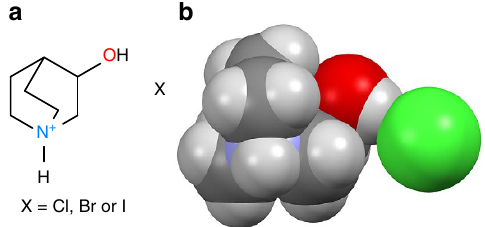
Figure 1 | Chemical structures of ( R )-( (cid:2) )-3-hydroxlyquinuclidinium halides. ( a ) Structural formula of ( R )-( (cid:2) )-3-hydroxlyquinuclidinium halides. ( b ) The space-filling drawing of ( R )-( (cid:2) )-3-hydroxlyquinuclidinium chloride ( 1 ), showing the globular geometries of both the cation and the anion.